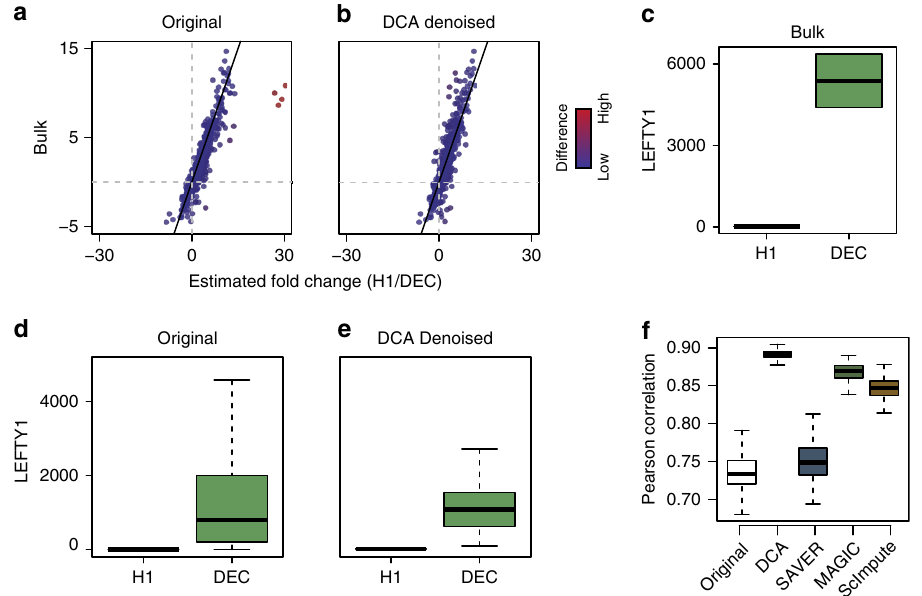
Fig. 5 DCA increases correspondence between single-cell and bulk differential expression analysis. Scatterplots depict the estimated log fold changes for each gene derived from differential expression analysis using bulk and original scRNA-seq count matrix ( a ), DCA denoised count matrix ( b ). Grey horizontal and vertical lines indicate zero log fold change. Black line indicates identity line. Points are colored by the absolute difference between log fold changes from bulk and single-cell data with red colors indicating relative high differences. c – e depict differential expression of an exemplary gene LEFTY1 between H1 and DEC for the bulk, original and DCA denoised data, respectively. f illustrates boxplots of the distribution of Pearson correlation coef fi cients from bootstrapping differential expression analysis using 20 randomly selected cells from the H1 and DEC populations for all denoising